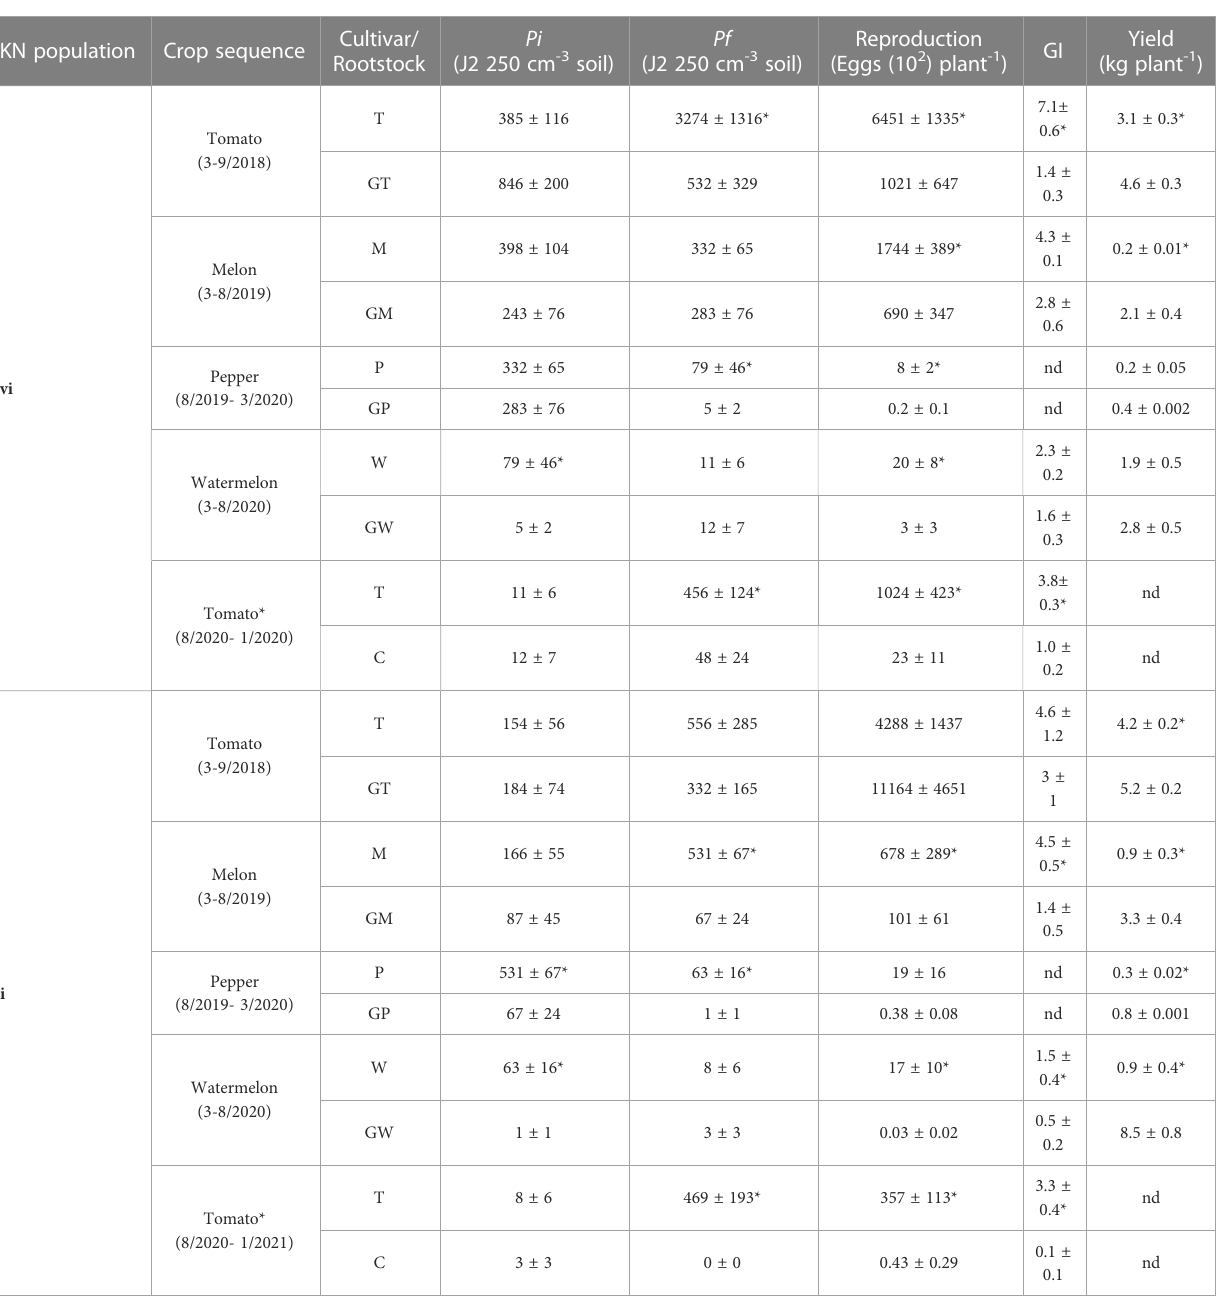
TABLE 1 Nematode soil densities at transplanting ( Pi ) and at the end of the crop ( Pf ), nematode reproduction (eggs plant -1 ), galling index and yield (kg plant -1 ) of the rotation sequence Tomato cv. Durinta (T)-melon cv. Paloma (M)-pepper cv. Tinsena (P)-watermelon cv. Sugar Baby (W), ungrafted or grafted onto the resistant rootstocks “ Brigeor ” (GT), Cucumis metuliferus (GM), “ Oscos ” (GP) and Citrullus amarus (GW), respectively, followed by a susceptible tomato cv. Durinta (T) or resistant tomato cv. Caramba (C) respectively, cultivated in a plastic greenhouse located at Viladecans (Spain) infested with a Mi1.2 avirulent (Avi) and a partially virulent (Vi) Meloidogyne incognita populations from to